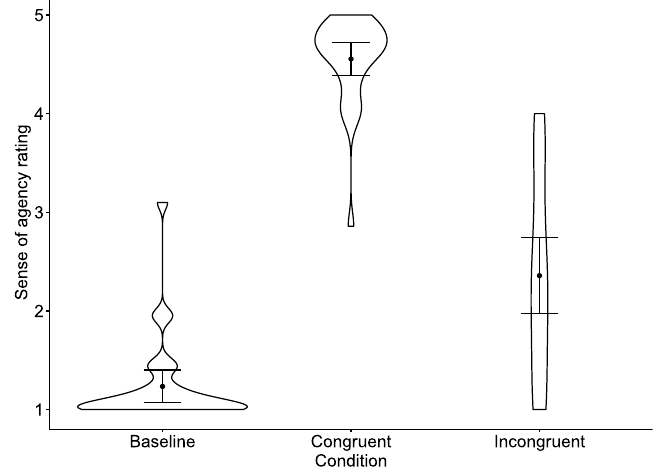
Figure 2. Sense of agency rating score in Experiment 1. Black dots depict means. Error bars depict 95% confidence intervals. Violin plots show the data